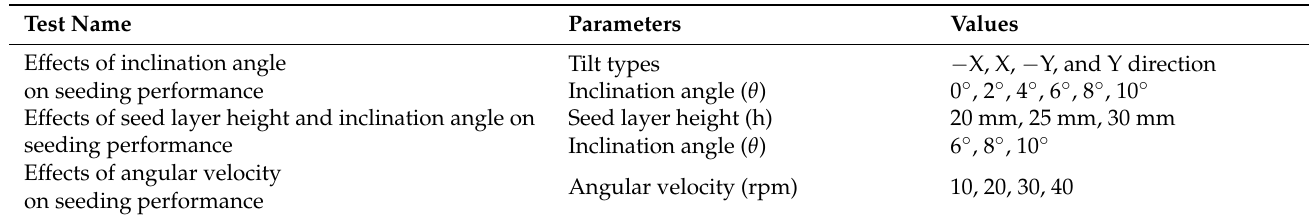
Table 2. Descriptions of the factors investigated in the simulation and the bench